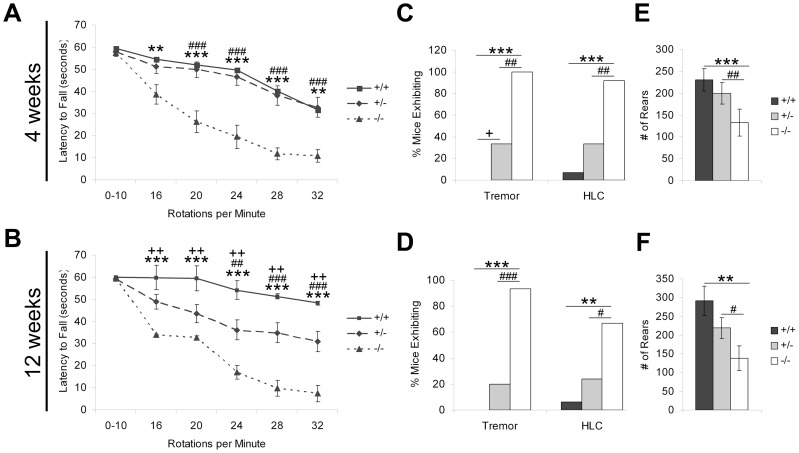
Severe motor impairment in PGC-1α −/− mice.PGC-1α +/+, +/−, and −/− littermates were assessed for motor coordination with rotarod analysis, for the presence or absence of tremor and hindlimb clasping (HLC), and for alterations in locomotor activity with open field monitoring at four and twelve weeks of age. A. At four weeks, PGC-1α −/− mice had a significantly decreased latency to fall off the rotarod apparatus compared to +/+ and +/− mice at speeds of 16, 20, 24, 28, and 32 rotations per minute. B. By twelve weeks of age, +/−, in addition to −/−, mice were significantly impaired on the rotarod task compared to +/+ animals. C. At four weeks, PGC-1α −/− and +/− mice had significantly increased instance of tremor compared to +/+ mice. PGC-1α −/−, but not +/−, mice had increased instance of HLC. D. PGC-1α −/−, but not +/−, animals had increased instance of tremor and HLC at twelve weeks. E–F. PGC-1α −/− mice exhibited fewer rears in the open field paradigm compared to +/+ and +/− littermates at four (E) and twelve (F) weeks of age. Other open field measures, including ambulatory distance and time, did not differ among genotypes. For A–B, repeated-measures ANOVA followed by planned comparisons with the Holm-Bonferroni correction. * +/+ versus −/−. + +/+ versus +/−. # +/− versus −/−. For C–D, chi-square tests for independence. For E–F, one-way ANOVA followed by Fisher's LSD. One symbol, p<0.05. Two symbols, p<0.005. Three symbols, p<0.0005. +/+ n = 17, +/− n = 25, −/− n = 15. Data presented as mean ± SEM.